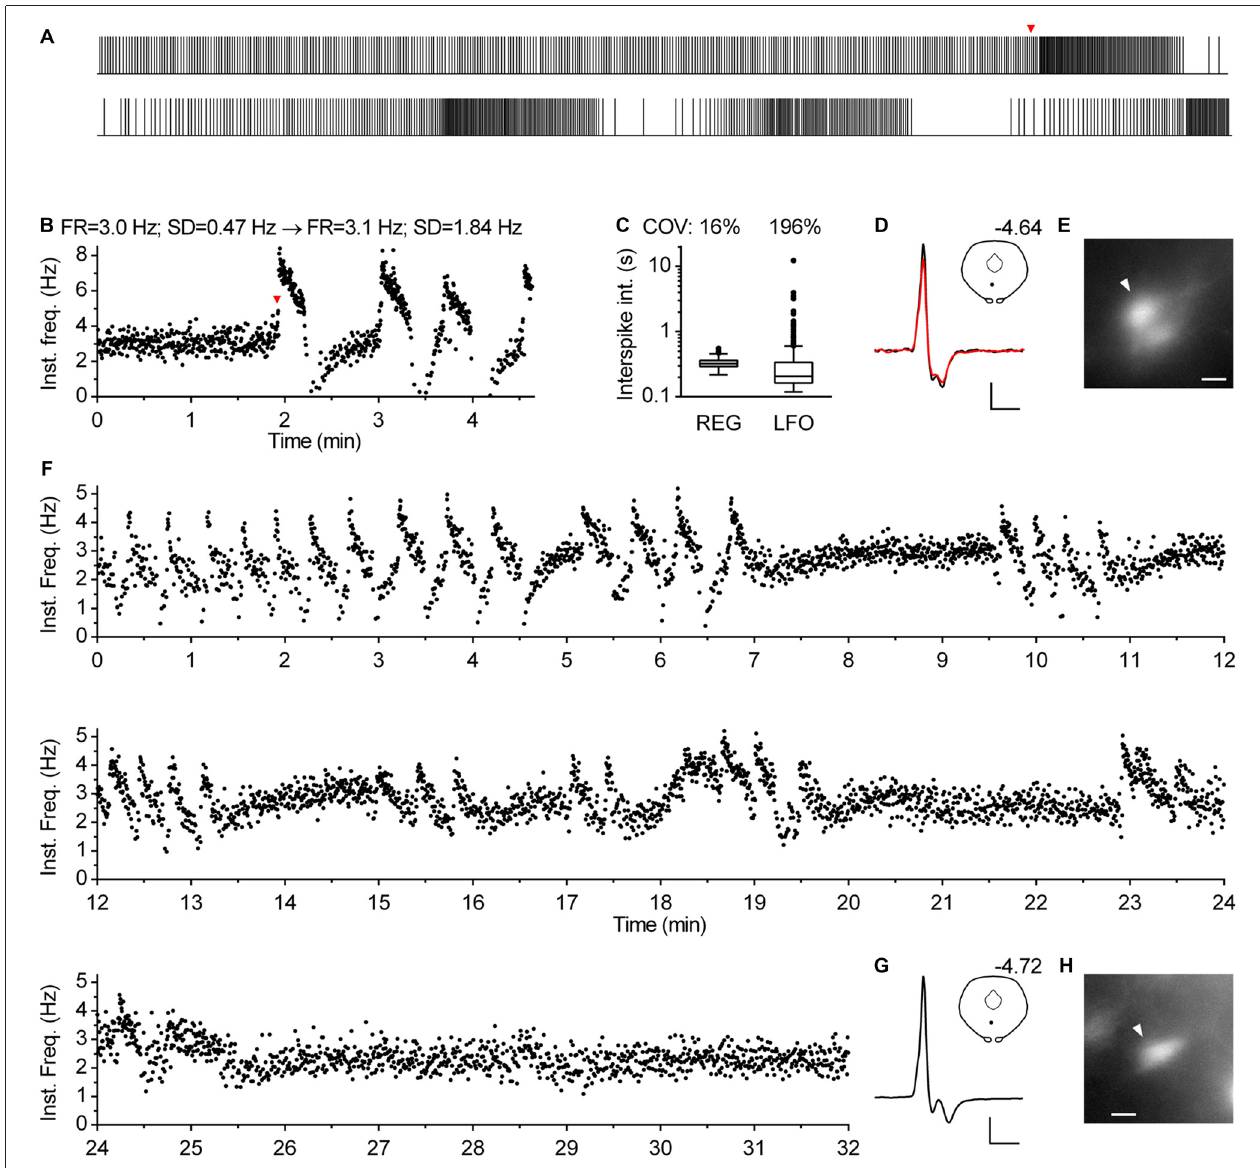
FIGURE 10 | Serotonergic neurons can spontaneously change spiking pattern. (A–E) Spontaneous transition from regular to oscillatory firing of a serotonergic neuron in TSC mouse. NA-induced firing. (A) Spike train. The bottom part is a continuation of the upper one. Overall duration is 278 s. Firing pattern changed from regular to oscillatory at 115 s (indicated by red arrowhead). (B) Time-course of instantaneous frequency of the train shown in (A) . Firing rate (FR) was similar during regular firing (0–115 s) and over the course of three full cycles of low-frequency oscillations (115–273 s), while standard deviation of instantaneous frequency (SD) notably increased. (C) Box plot shows distribution of ISI during regular firing segment (REG, 0–115 s) and during the segment of three cycles of low-frequency oscillations (LFO, 115–273 s). Log scale. Boxes represent median and the IQR. Whiskers denote 1.5 IQR. COV denotes coefficient of variation of ISI. (D) Superimposed average traces of spikes recorded during regular (black line) and oscillatory firing (red line). Scale bars: 15 pA, 1 ms. Inset shows the anatomical location of the neuron. The number indicates distance from bregma. (E) Fluorescence image of the recorded neuron. Scale bar: 10 µ m. (F–H) Prolonged recording from a serotonergic neuron exhibiting LFO. PRY mouse, PE-induced firing. (F) Time-course of instantaneous frequency shows multiple transitions in firing pattern. (G) Average spike. Scale bars: 15 pA, 1 ms. Inset shows the anatomical location of the neuron. The number indicates distance from bregma. (H) Fluorescence image of the recorded neuron. Scale bar: 10 µ